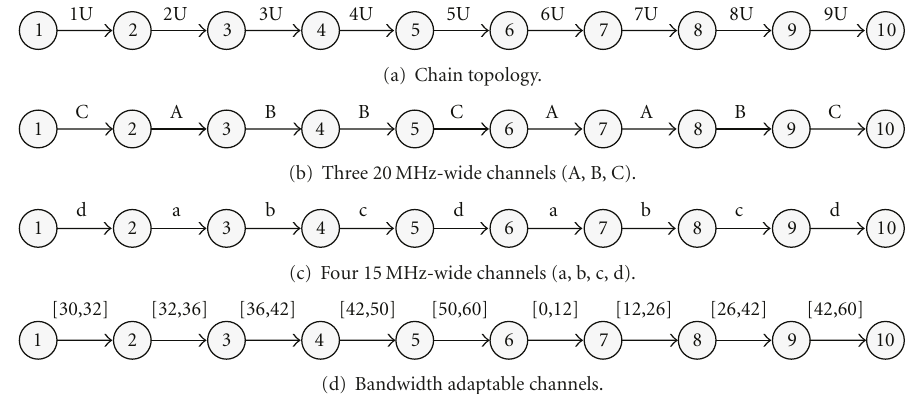
Figure 2: Scenarios illustrating the ine ffi ciency of using channels with fixed predetermined width. In Figure 2(d), above each link, [ x , y ] denotes the frequency interval ranging from x MHz to y MHz which is assigned to that